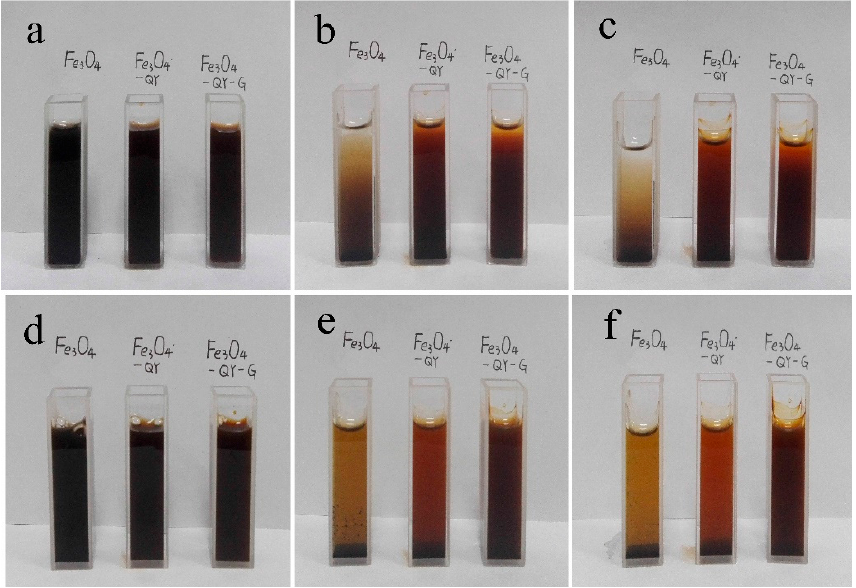
Figure 4. Solvent-dependent stability pictures of nanoparticles ( a ) 0 h in water, ( b ) 24 h in water, ( c ) 48 h in water, ( d ) 0 h in human serum, ( e ) 24 h in human serum, ( f ) 48 h in human serum.